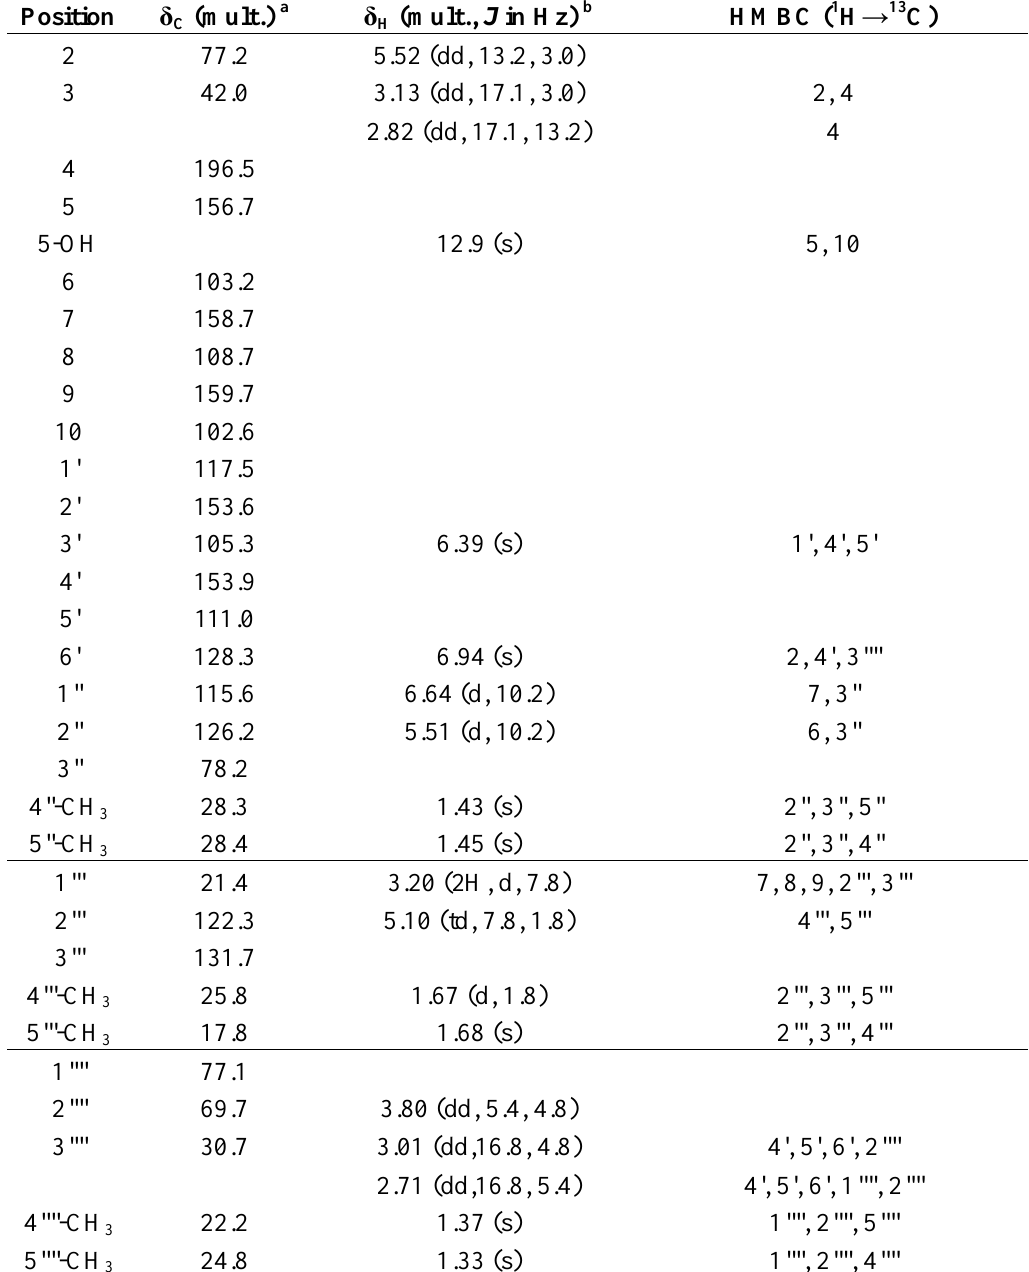
Table 2. 13 C, 1 H and HMBC data for flemichin E ( 2